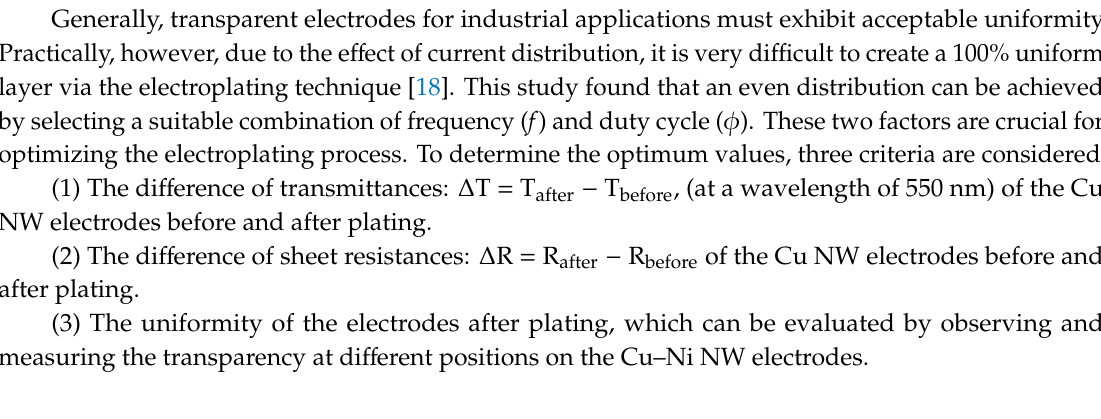
a) b) Figure 8. The change in ( a ) sheet resistance— Δ R and ( b ) transmittance— Δ T after nickel plating with various frequencies ( f ) and duty cycles ( ϕ ). Generally, transparent electrodes for industrial applications must exhibit acceptable uniformity. Practically, however, due to the effect of current distribution, it is very difficult to create a 100% uniform layer via the electroplating technique [18]. This study found that an even distribution can be achieved by selecting a suitable combination of frequency ( f ) and duty cycle ( ϕ ). These two factors are crucial for optimizing the electroplating process. To determine the optimum values, three criteria are considered: (1) The difference of transmittances: Δ T = T after − T before , (at a wavelength of 550 nm) of the Cu NW electrodes before and after plating. (2) The difference of sheet resistances: Δ R = R after − R before of the Cu NW electrodes before and after plating. (3) The uniformity of the electrodes after plating, which can be evaluated by observing and measuring the transparency at different positions on the Cu–Ni NW electrodes.